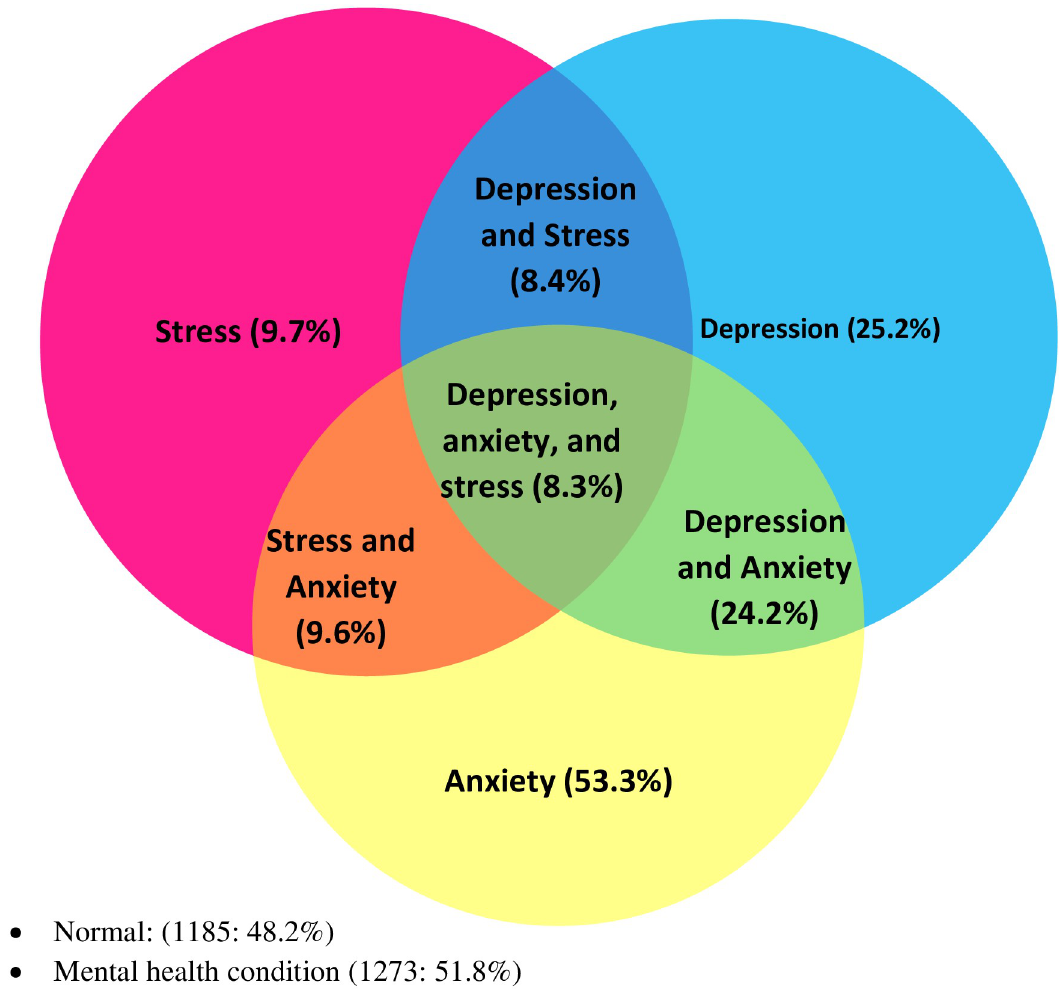
Fig 1. Prevalence of depression, anxiety and